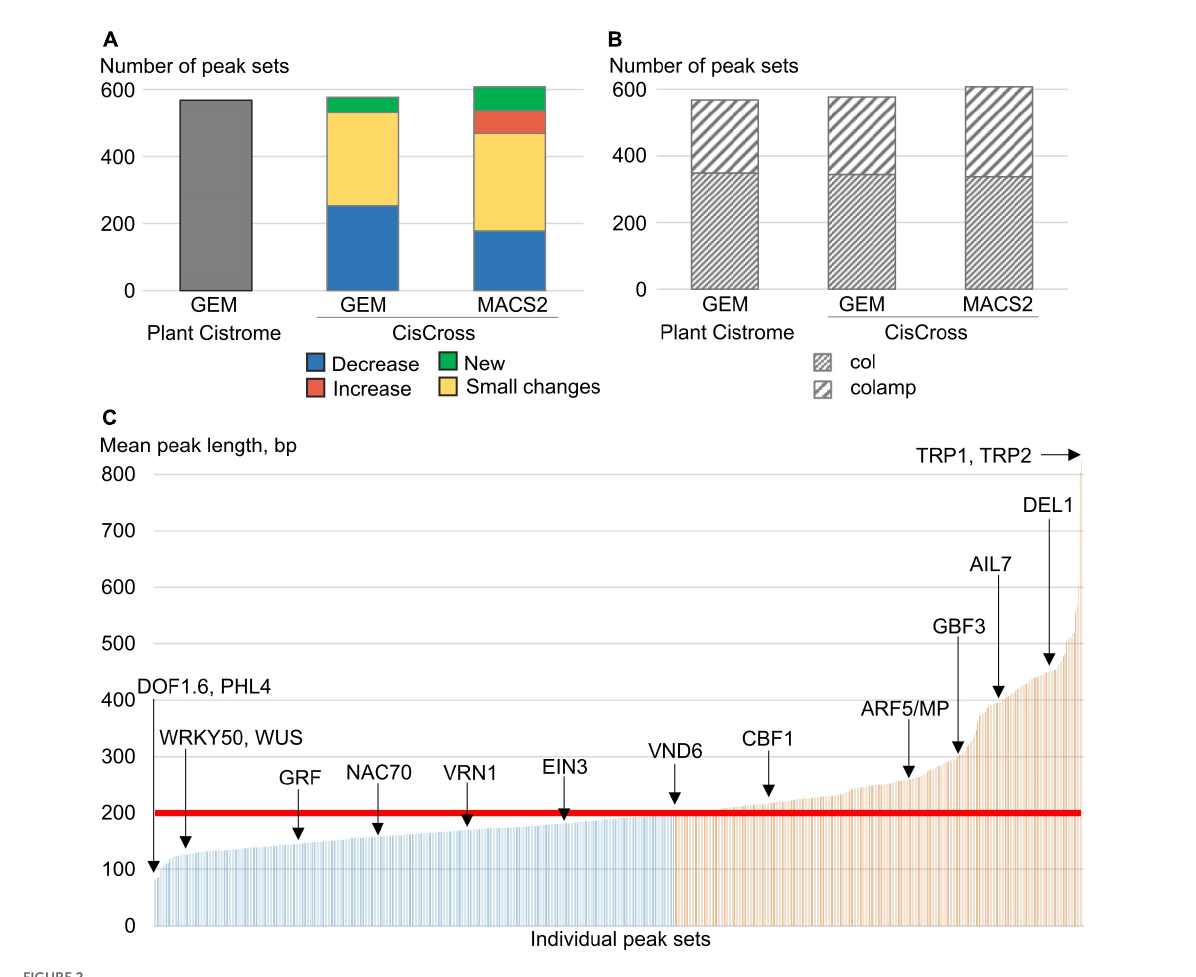
FIGURE2 Summary statistics on the Plant Cistrome, CisCross-GEM, and CisCross-MACS2 versions of the DAP-seq peak set collection. (A) The total number of peak sets. “New” implies sets missing in the Plant Cistrome version. “Increase”/“Decrease” means that the number of peaks in sets increased/decreased at least twofold; “Small changes” indicates any smaller changes. X -axes in panels (A,B) denote the version of the DAP-seq collection. (B) The number of col and colamp peak sets in three versions of the DAP-seq collection. (C) Distribution of mean peak length ( Y -axis) in individual peak sets ( X -axis) for the CisCross-MACS2 version of the DAP-seq collection. Red line denotes the fixed peak length in the Plant Cistrome version (200 bp). Blue/orange colors mark the peak sets with shorter/longer mean peak length. A few example peak sets are